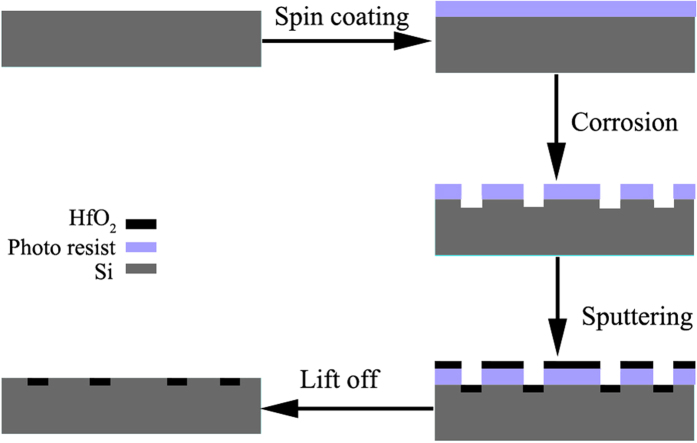
Flow-process illustration for the HfO2 filled porous Si with microcavities.